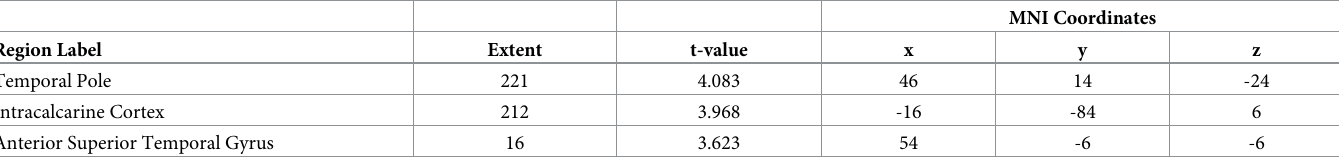
MNI Coordinates